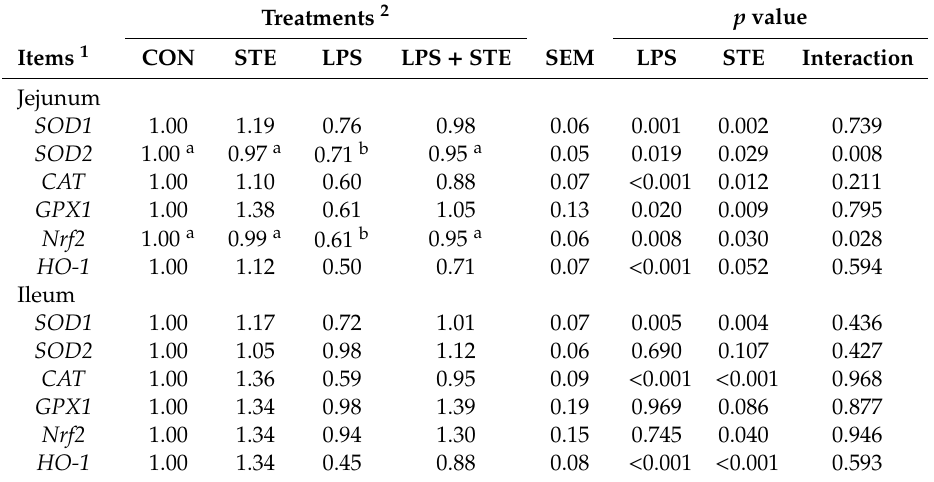
Table 8. E ff ects of stevioside supplementation on antioxidant gene expression in the intestinal mucosae of LPS-challenged